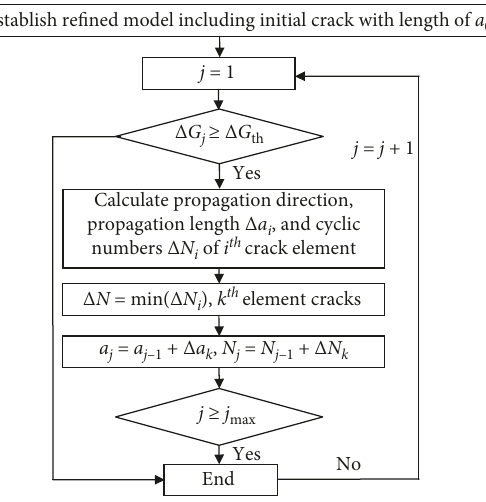
Figure 4: Simulation flow of the fatigue crack propagation